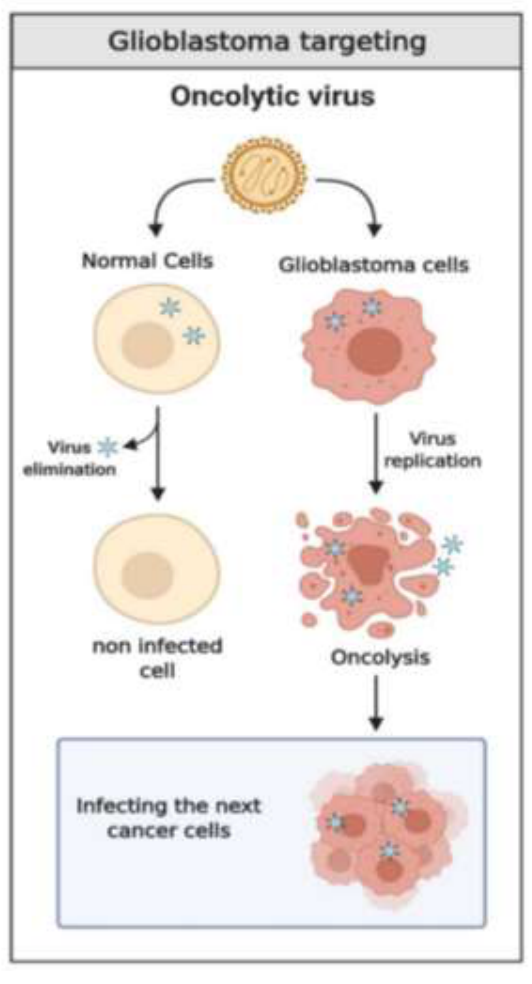
Figure 8: The proposed mechanism for NDV-AMHA1 strain against Iraqi patient-derived glioblastoma